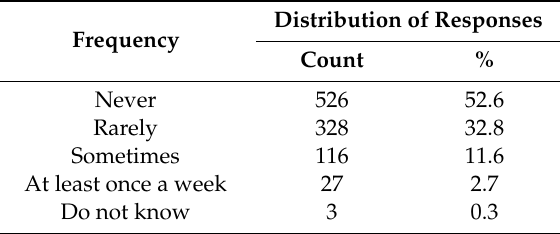
Table 5. The distribution of responses to the question: “Do you go on eating binges even though you are not hungry?” ( n = 1000).